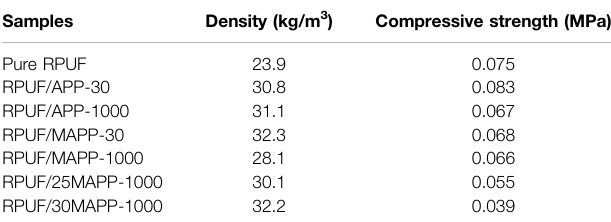
TABLE 5 | Mechanical properties of